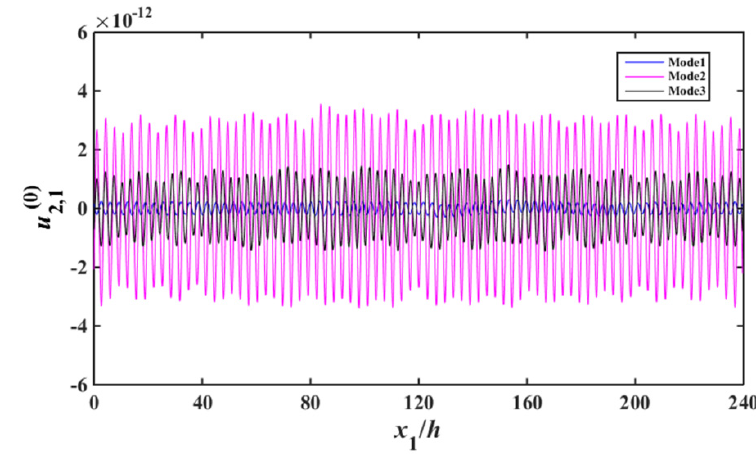
( 0 ) ( ) 0 u ). 2,1 2,1 ( ) 0 u ). 2,1